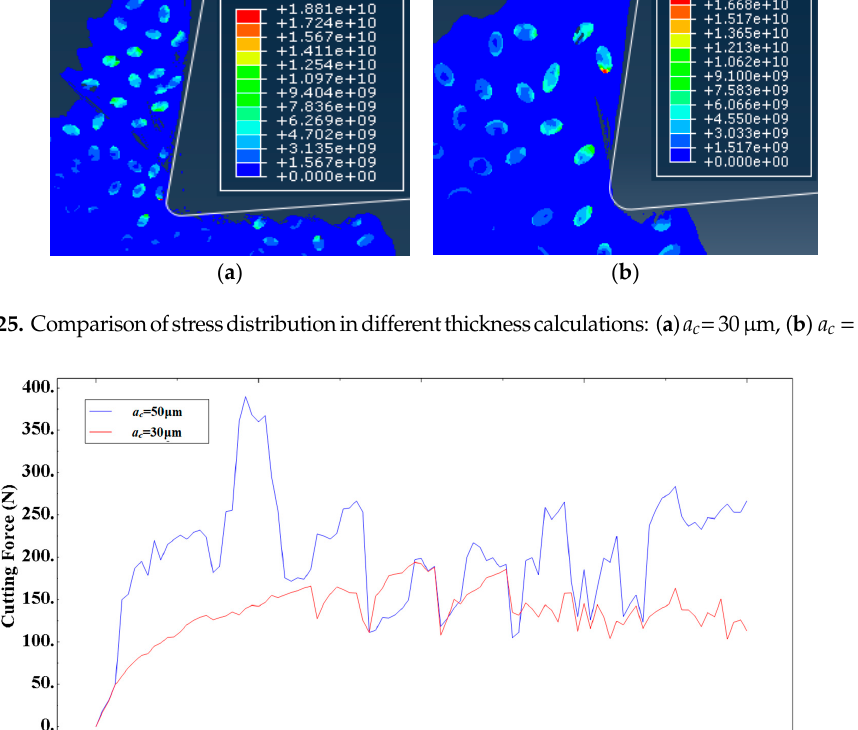
Figure 26. Comparison of cutting forces for different cutting thickness calculations.